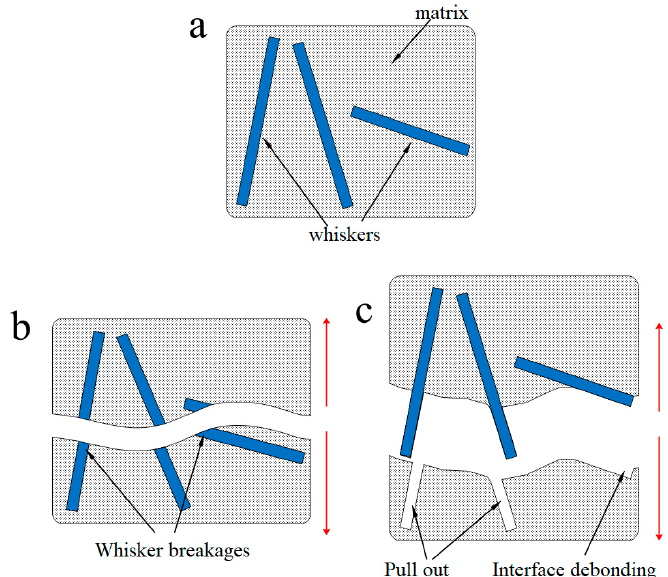
Figure 12. Schematics showing the creep fracture mode for the whisker-reinforced composite: ( a ) microstructure of the ABOw/Al–12Si composite before creep; ( b ) creep fracture mode after the tensile creep test at 300 °C; and ( c ) creep fracture mode after the tensile creep test at 400 °C.